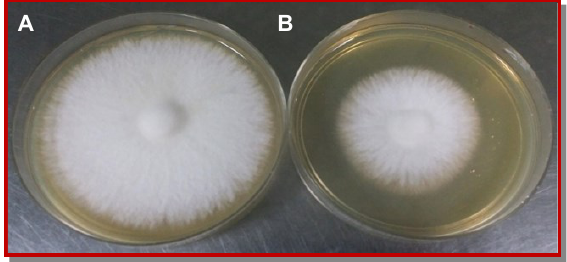
Figure 1: The growth of Microsporum fulvum IBRL SD3 for 20 days without (A) or with (B) fumigation to the culture of endo- phytic fungus, IBRL